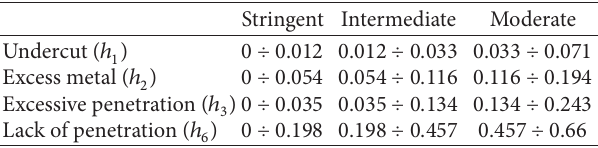
Table 7: Limits for imperfections for quality levels